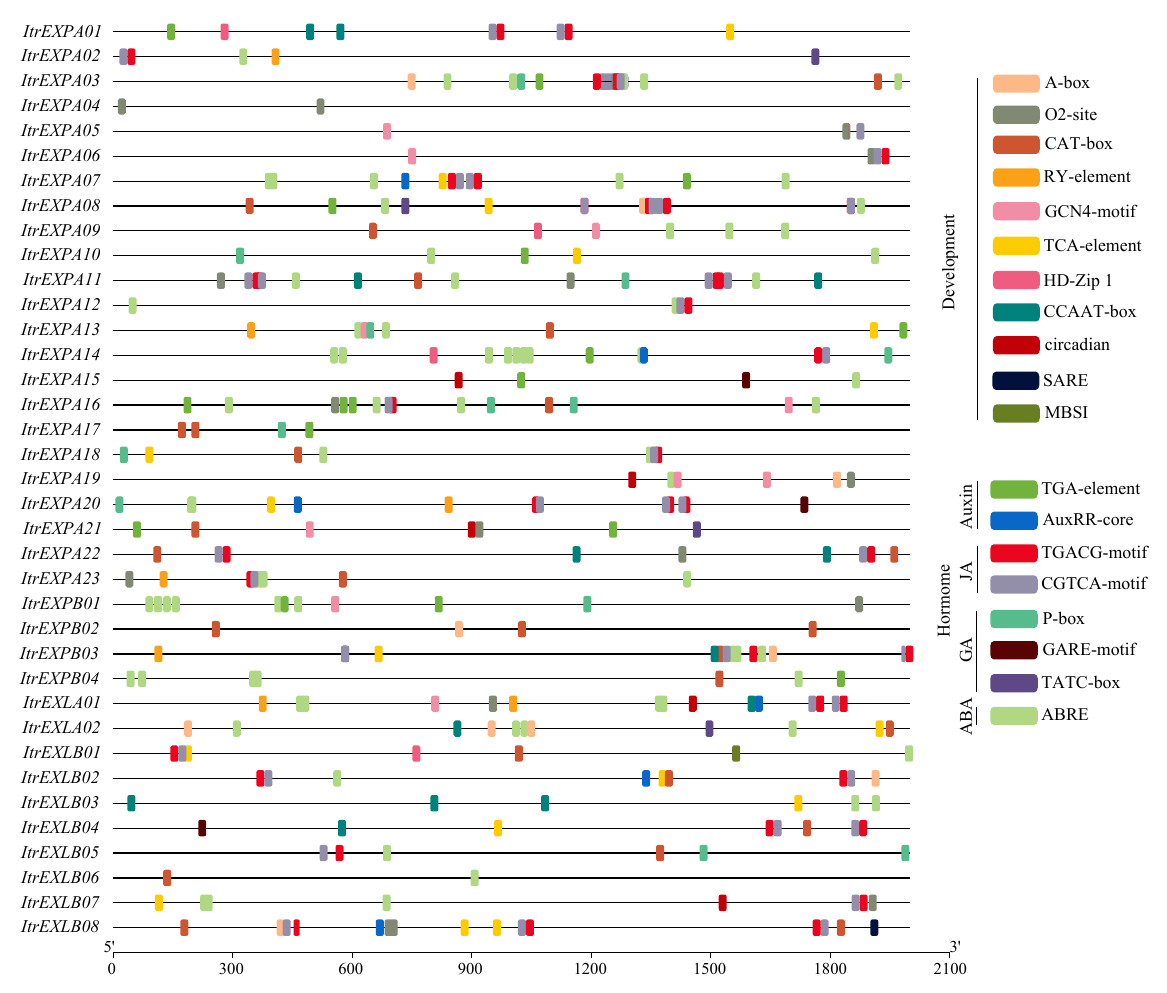
Figure 4. Potential cis -element prediction in the promoter regions of ItrEXPs . Left part shows the locations of cis -elements in the promoter regions, right part shows the cis -element types and their